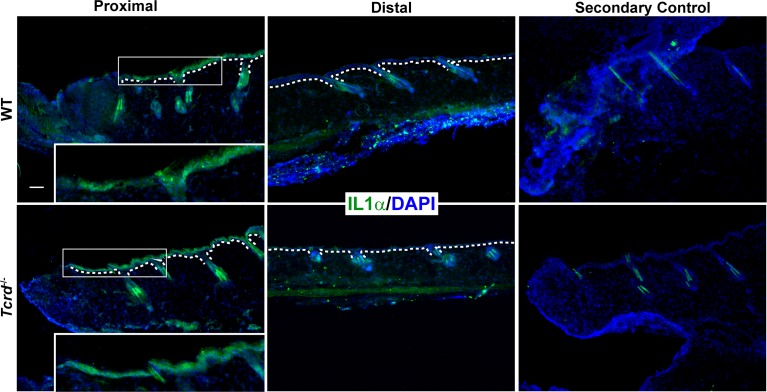
Representative image of day one post-wound in Figure 2—figure supplement 6.Unpermeabilized skin sections from WT or γδT-cell KO mice were stained for extracellular IL-1α. Regions shown are proximal to the wound and 2 cm distal to the wound site. The secondary control comprises sections stained only with secondary antibody. Boxed regions are shown as magnified images in the inset. White dotted lines denote the basement membrane that separates the epidermis from the underlying dermis. Scale bar = 50 μm.